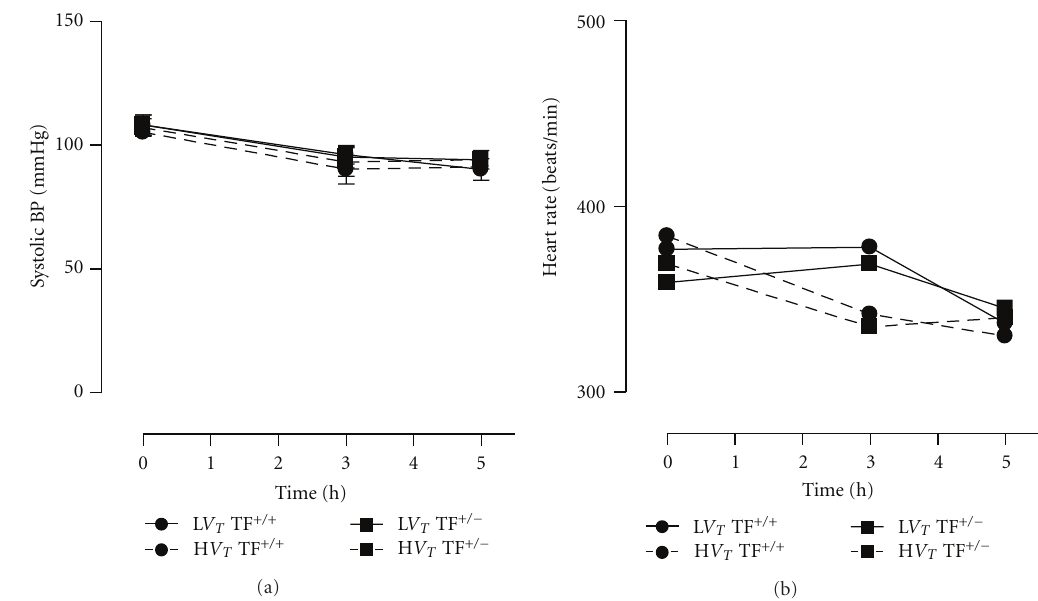
Figure 1: Hemodynamic parameters during 5 hours of mechanical ventilation. Systolic blood pressure (a) and heart rate ((b); beats/min) were measured at three time points ( t = 0, 2.5, and 5 hours after start of mechanical ventilation) in mice ventilated with low tidal volumes (L V T ) and high tidal volumes (H V T ). Each mentioned group consisted of heterozygote TF knockout (TF + / − ) mice and their wild-type littermates (TF + / + ). Data represent means of 12 mice.